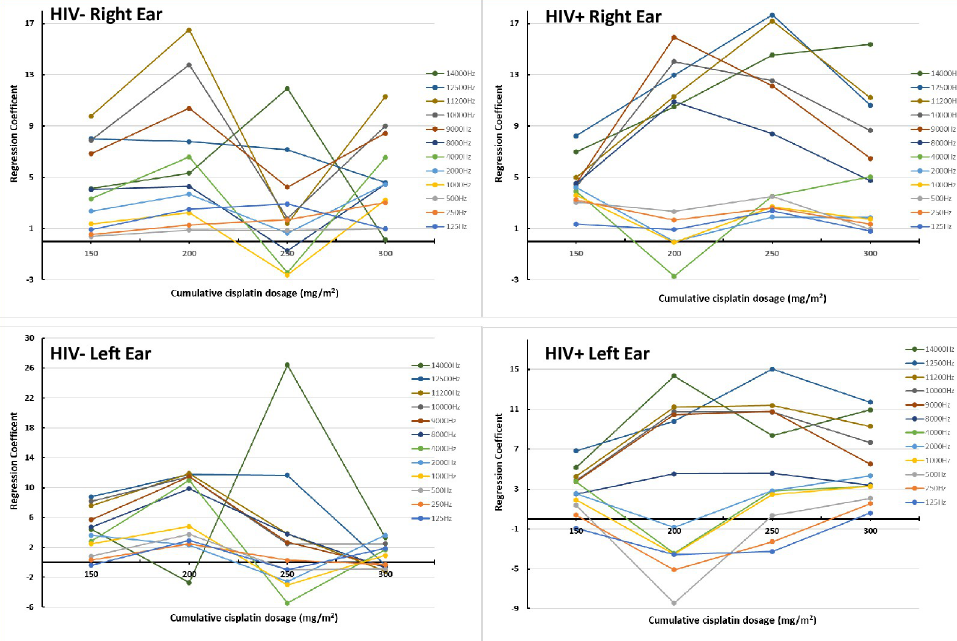
Fig 6. Influence of cumulative cisplatin dosage on hearing thresholds in the right and left ear in patients stratified by HIV status, after adjustment for age. Dose effect evident in HIV positive group only. The change in hearing threshold is also reached more quickly with a lower dosage in the HIV positive